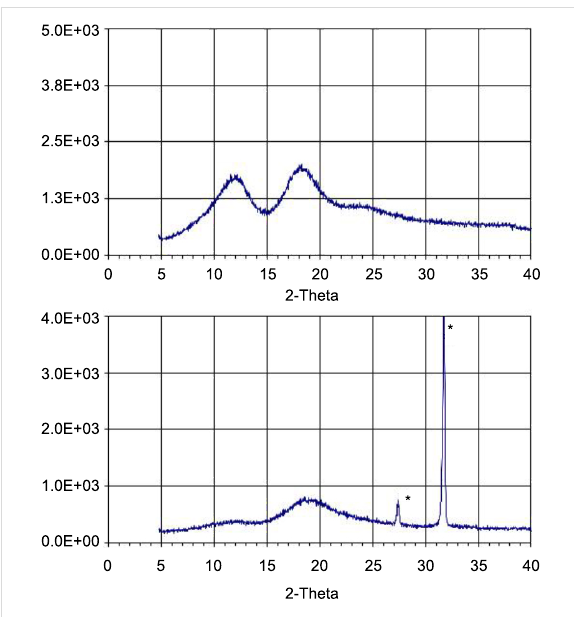
Figure 2: Top: XRPD pattern for CRYSMEB. Bottom: XRPD pattern for D1 polymer. The diffraction peaks denoted with an asterisk at 2 θ = 27.48° and 31.7° are due to the presence of traces of residual NaCl. The assignment was confirmed by collecting the XRDP in the 4–100° range of 2 θ and comparing the experimental profile with the literature pattern of pure NaCl.